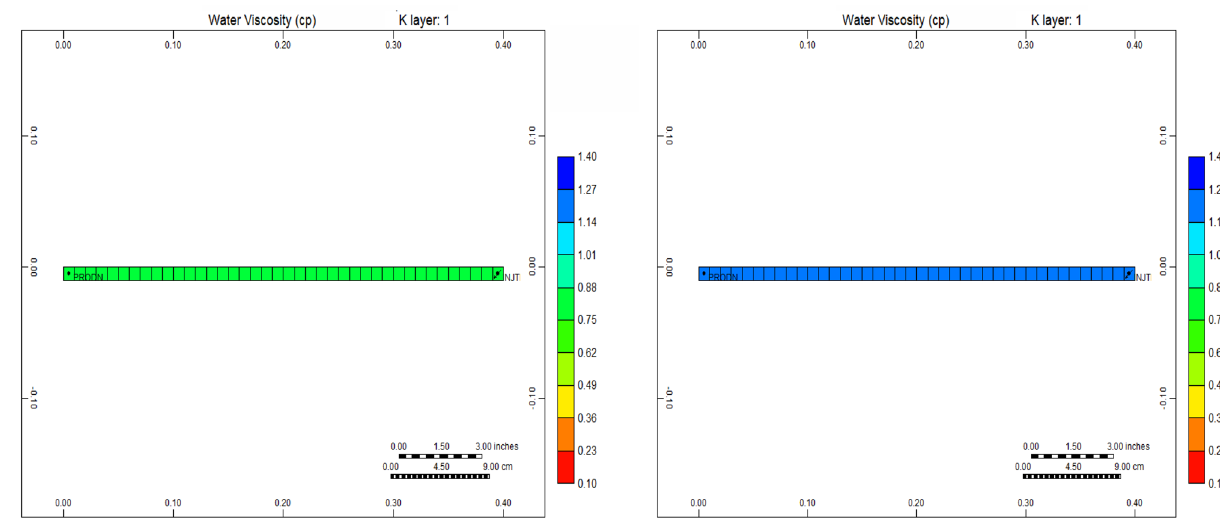
Fig. 7 Water viscosity variation per biomass increase. Start of simulation (left); End of simulation (right)